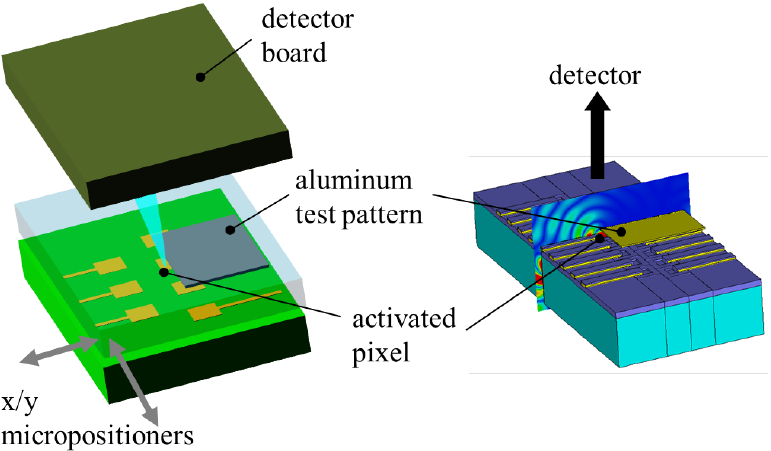
Figure 7. Schematic view of the scanning microscope setup, with a metallic EBL test pattern on top of the LED array, and the detector board on top. Only one LED is activated, and the metallic test pattern is moved over the LED by means of micropositioners. On the right, the shadowing of the electromagnetic field by an aluminum patch partly above the emitting LED is